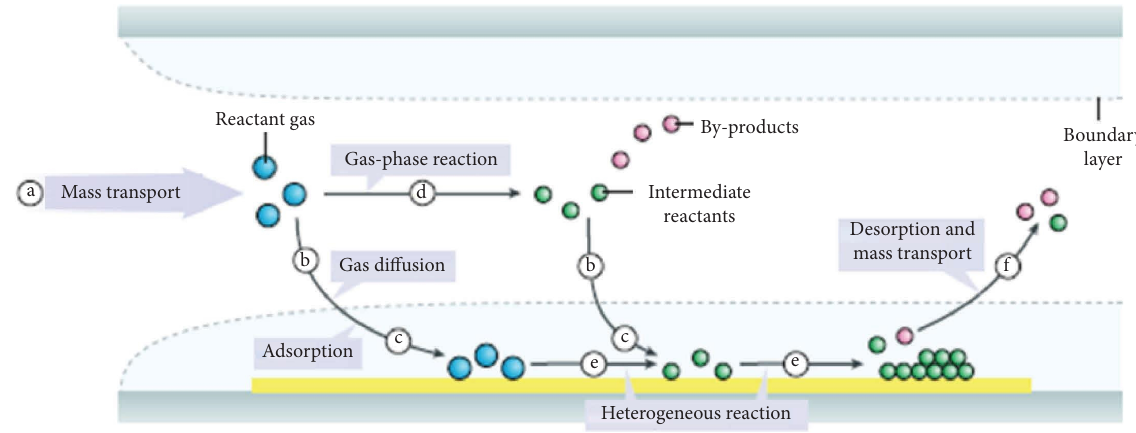
Figure 14: Graphene growth mechanism in CVD